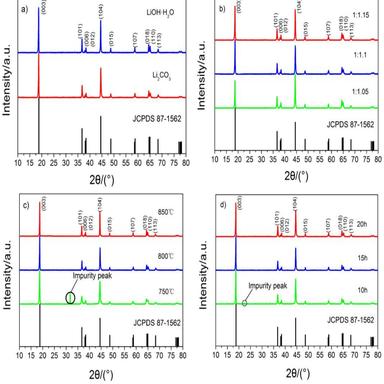
XRD patterns of cathode material under different conditions: (a) different lithium sources, (b) different ratios of precursors to lithium carbonate, (c) different calcination temperatures and (d) different calcination times.